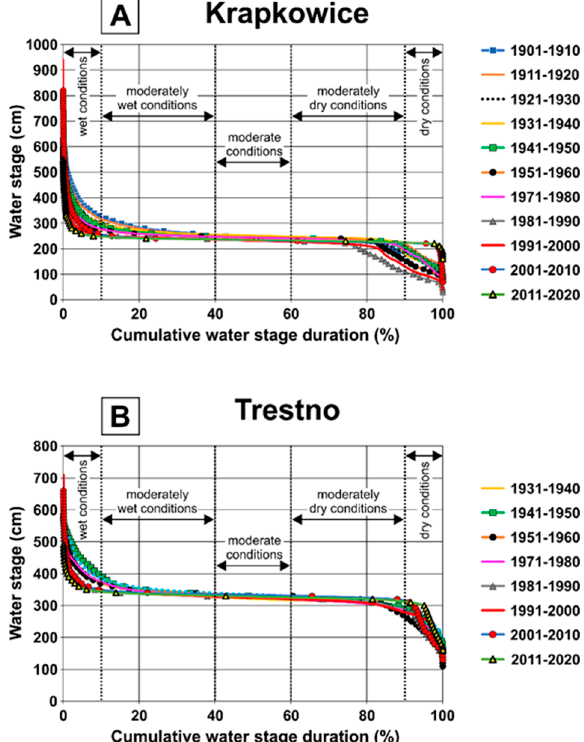
Figure 3. Water–stage duration curves for the Krapkowice ( A ) and Trestno ( B ) water–gauge stations from Section 2 of the Odra River.